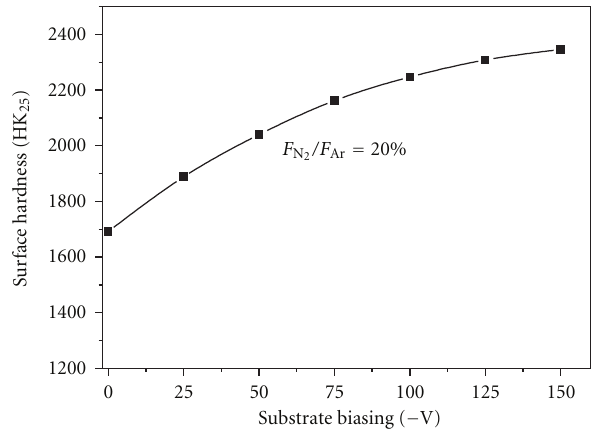
Figure 7: Surface hardness (at 25 gf) of Nb-N coatings on SS /F = 20%) versus substrate biasing. (deposited at F N Ar 2